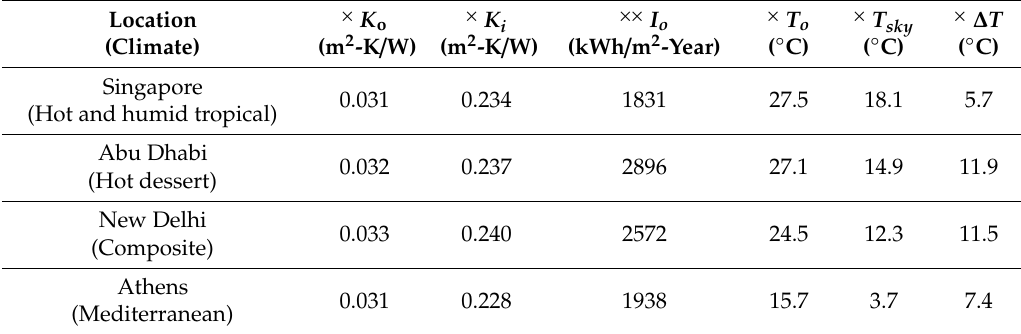
Figure 3. E ff ects of thermo-physical and solar radiation properties on ( a ) annual heat gain and ( b ) R eq in di ff erent climates ( Q represents the annual heat gain and K ρ and K coating represents thermal resistance due to both enhanced solar reflectance and cool coating layer). Table 3. Air film resistance of roof surfaces and weather conditions of selected